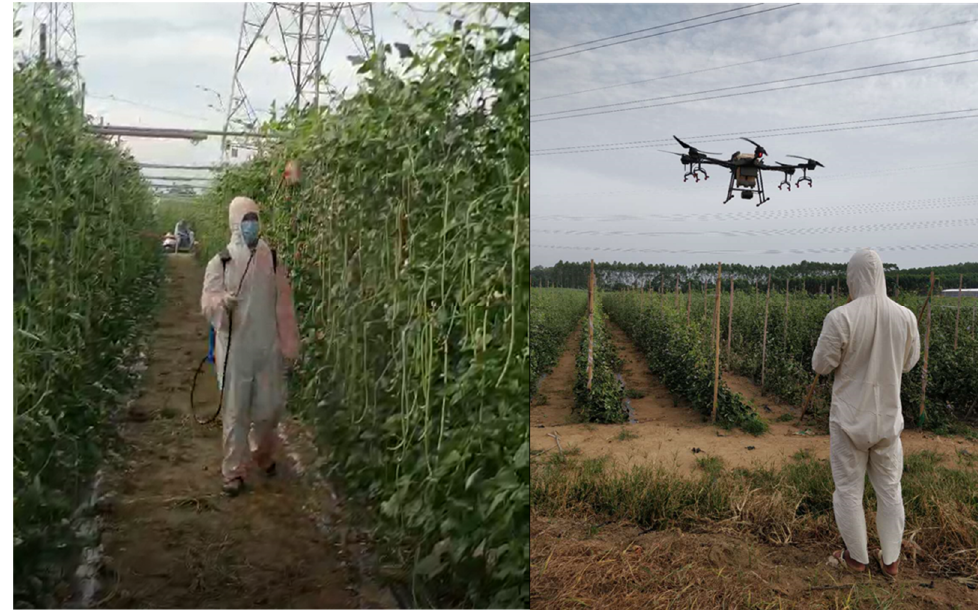
Figure 1. The typical scenarios of exposure determination of operator to Allure Red sprayed by knapsack electric and unmanned aerial vehicle (UAV) sprayers.